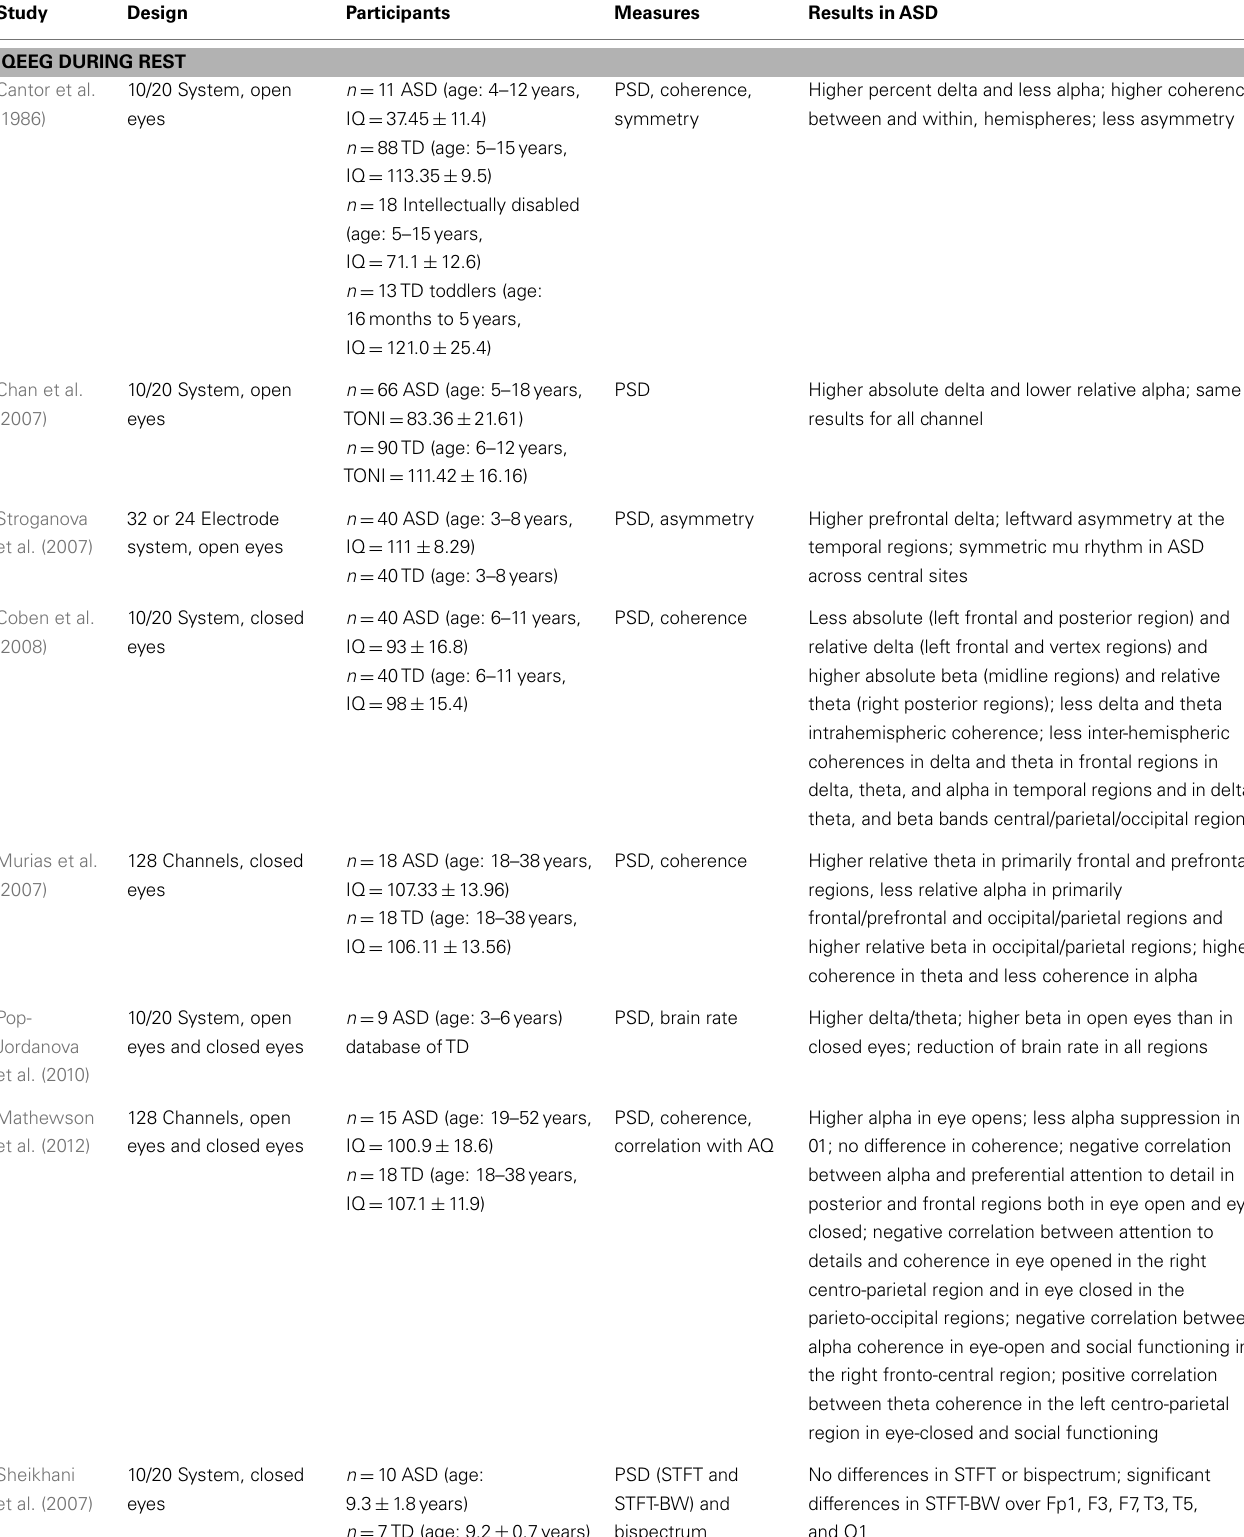
Table 1 | Summary of QEEG studies in